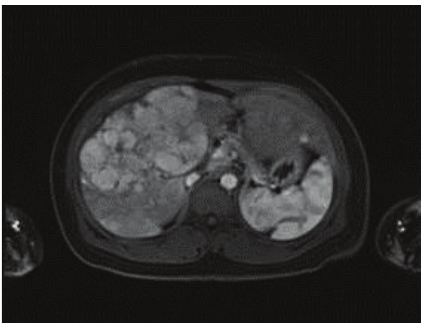
Figure 3: Immunohistochemical stain for CD34 performed on a core needle biopsy of the liver lesion highlights endothelial cells surrounding tumor cells (10x